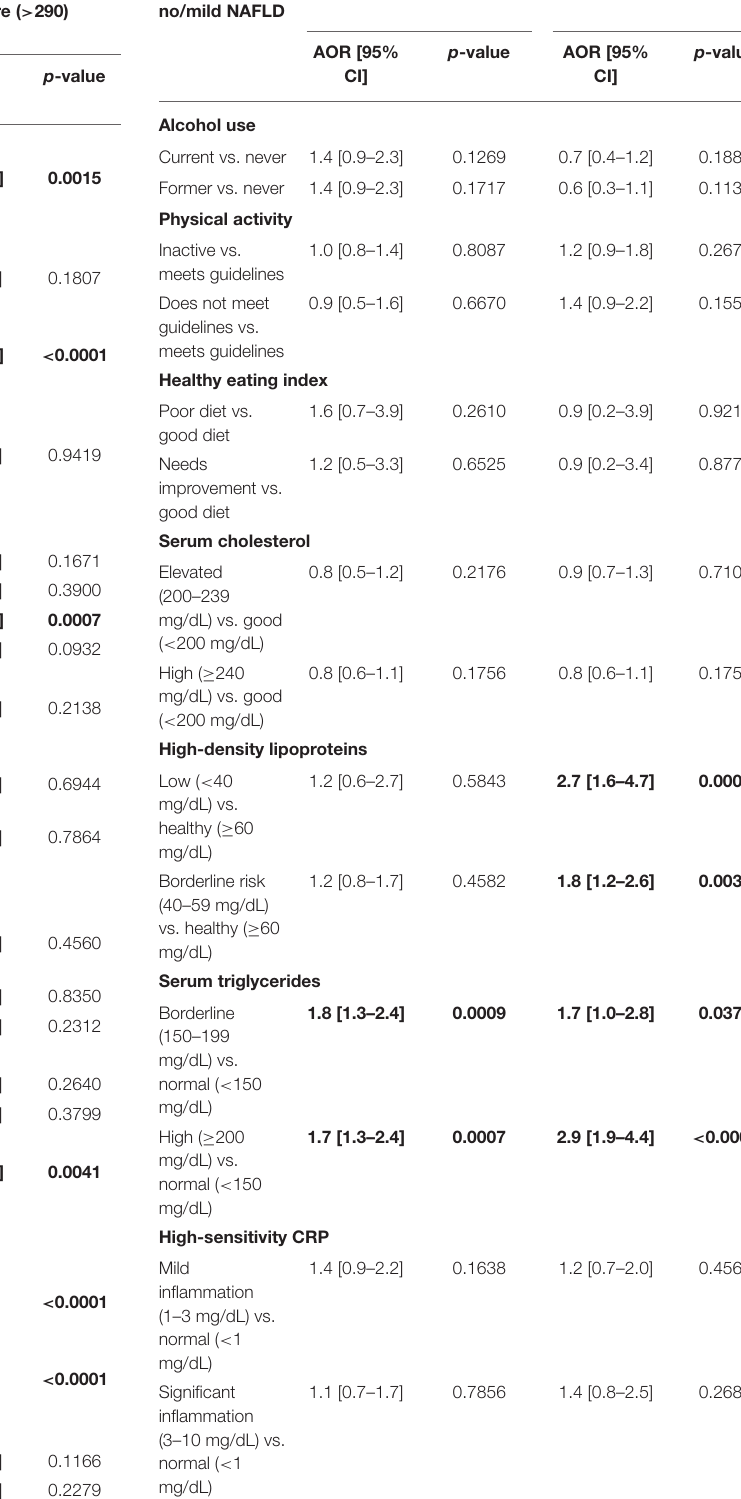
TABLE 4 | Adjusted odds ratio (OR) and 95% confidence interval (CI) for the relationship between NAFLD and race/ethnicity (reference = no/mild